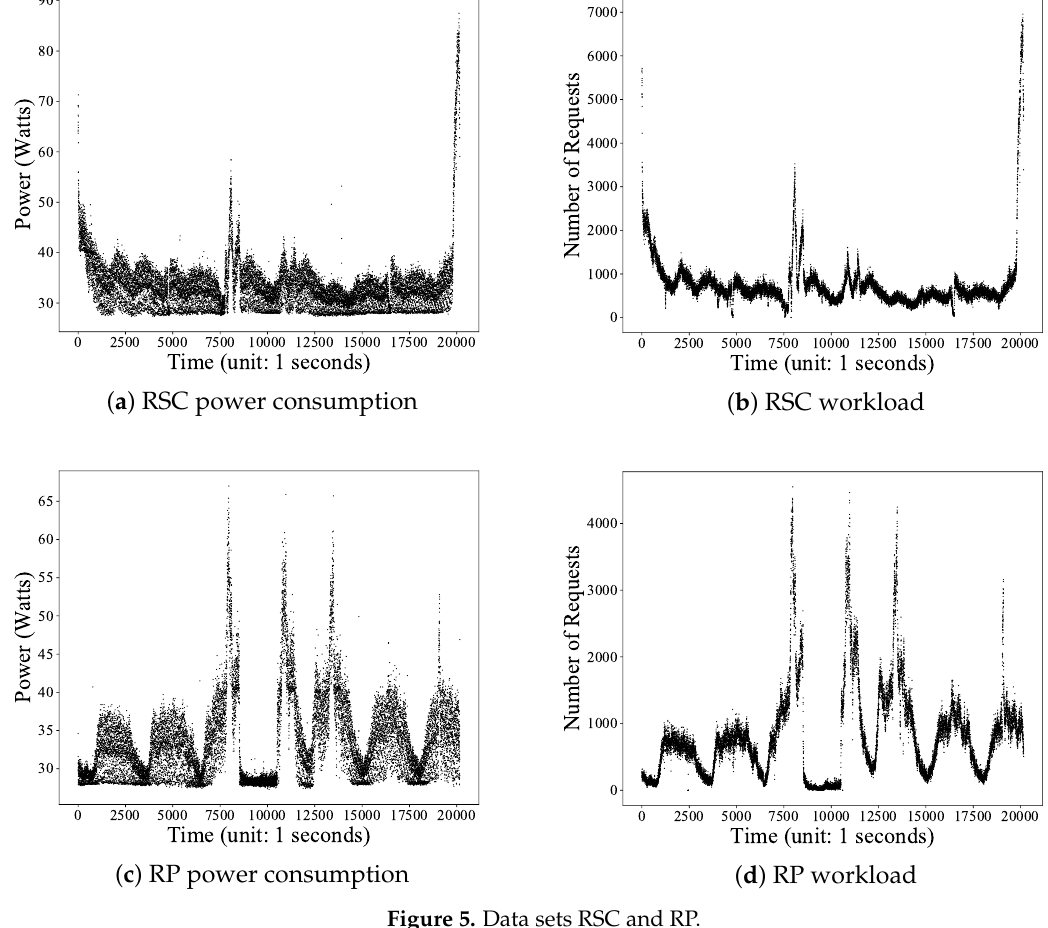
Figure 5. Data sets RSC and